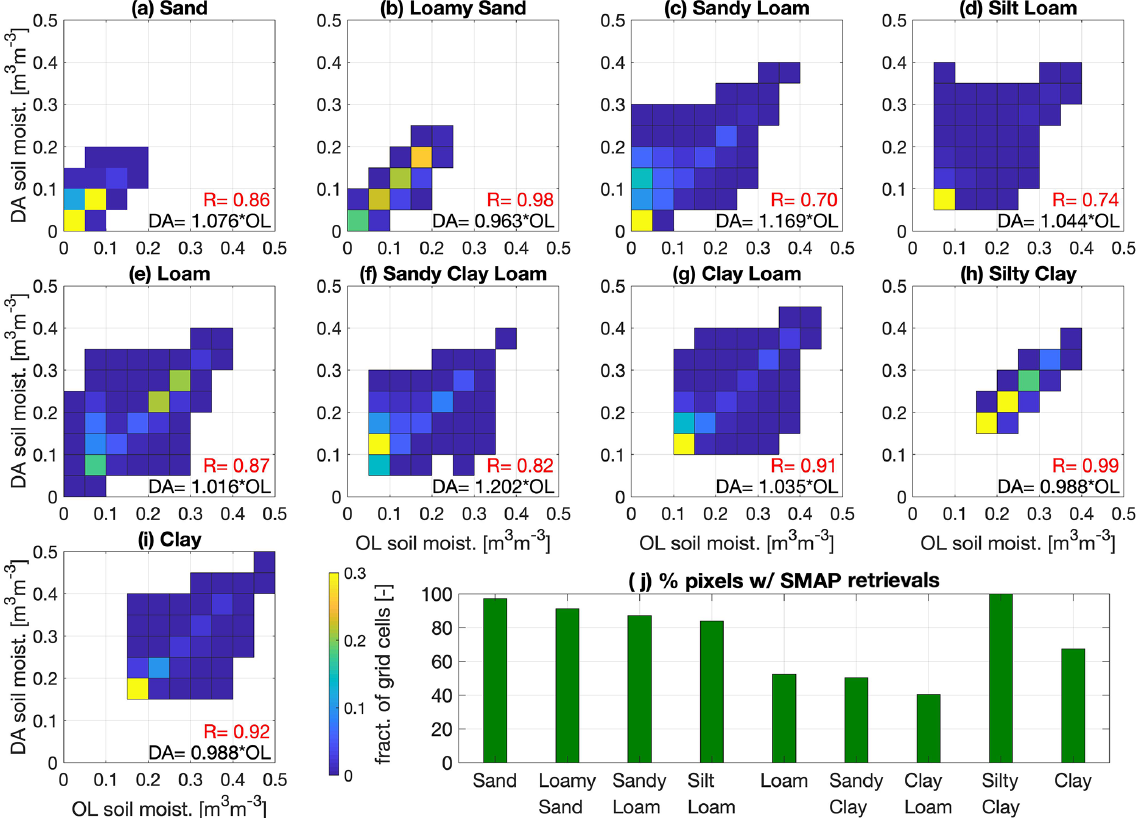
Figure C1. Comparison of OL- versus DA-NoCDF-estimated soil moisture according to the dominant soil texture types present within the study domain. The OL and DA-NoCDF joint PDFs (presented here as fractions of grid cells) are computed from the LIS runs with MERRA2 boundary conditions during the winter months of WY